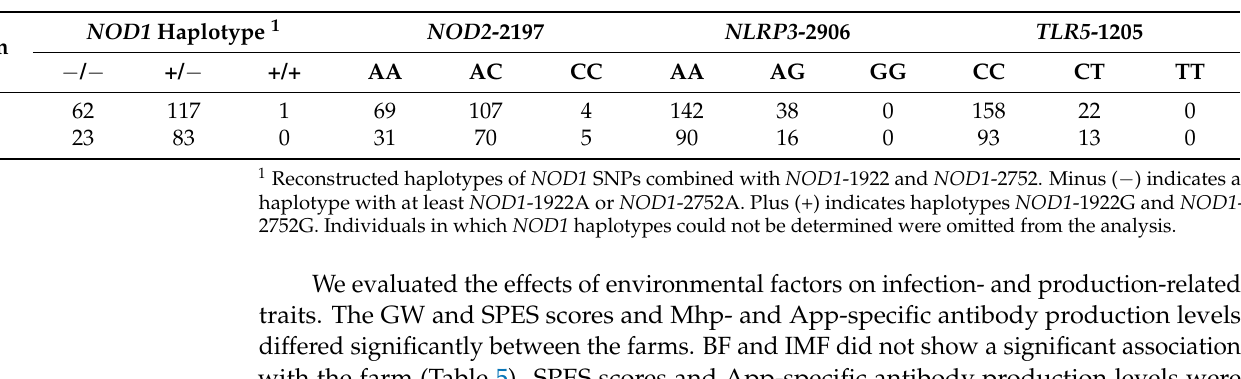
Table 4. Allele distribution of PRR genes in the pig populations.